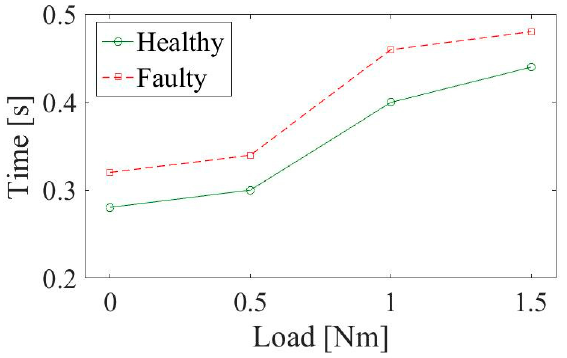
Figure 13. Comparison of the result of starting time under different loads.